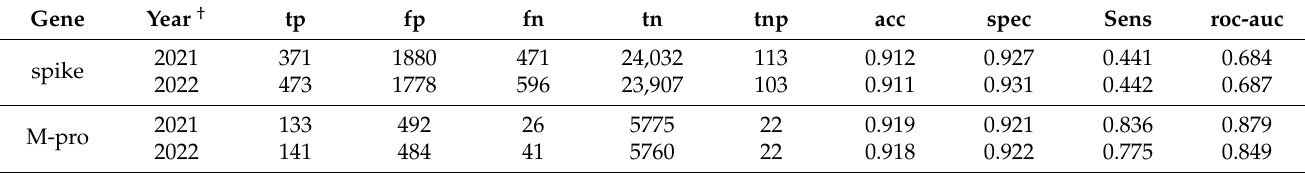
Table 4. Amino acid change predictions in M-pro and spike